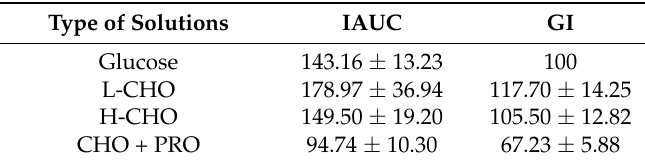
Table 2. Incremental area under the curve (IAUC) and glycemic index (GI) of prescribed sports beverage.